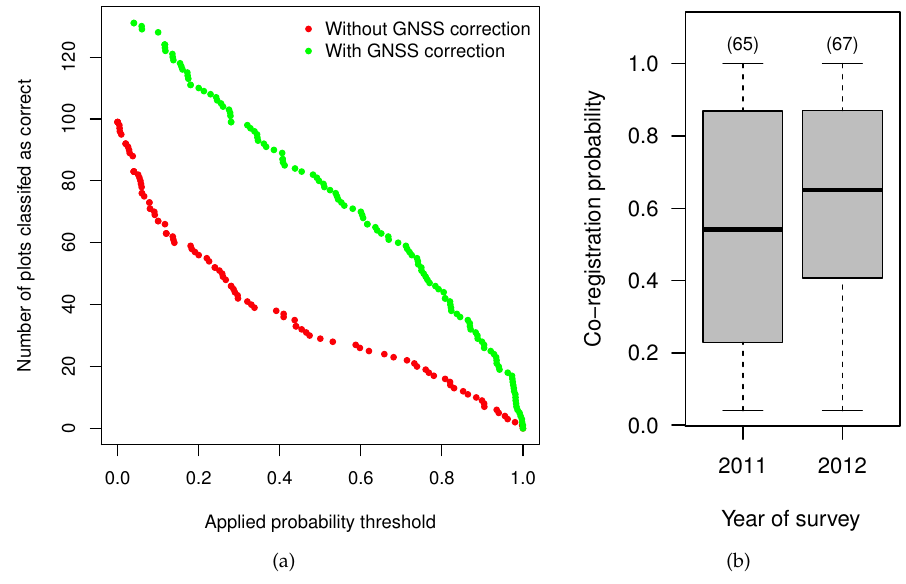
Figure 10. ( a ) Correlation between the applied probability threshold for a correct co-registration and the resulting number plots classified as correctly co-registered. ( b ) Effect of the year of survey on the co-registration probability. Both figures are based on the original BWI plots. The numbers in brackets correspond to the number of plots. GNSS: Global Navigation Satellite